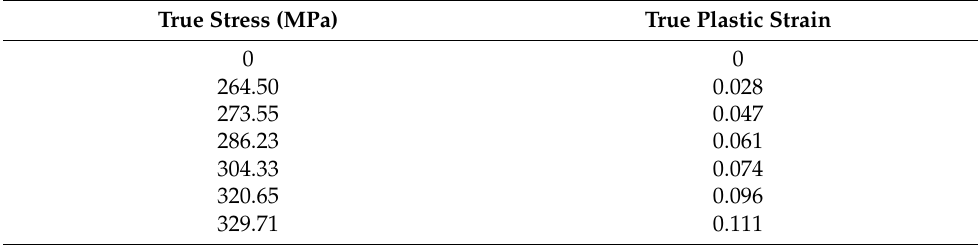
Table 1. True stress–true strain values given as input to the simulations in present study [2]. True Stress (MPa) True Plastic